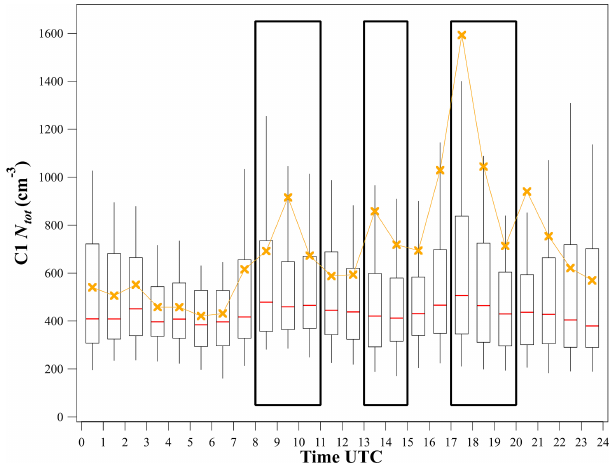
Figure 7. Box and whisker diurnal profile of N tot at C1 during sum- mer. N tot mean (orange x) and median (red line). Black boxes from 08:00–10:00, 13:00–15:00, and 17:00–20:00UTC indicate the